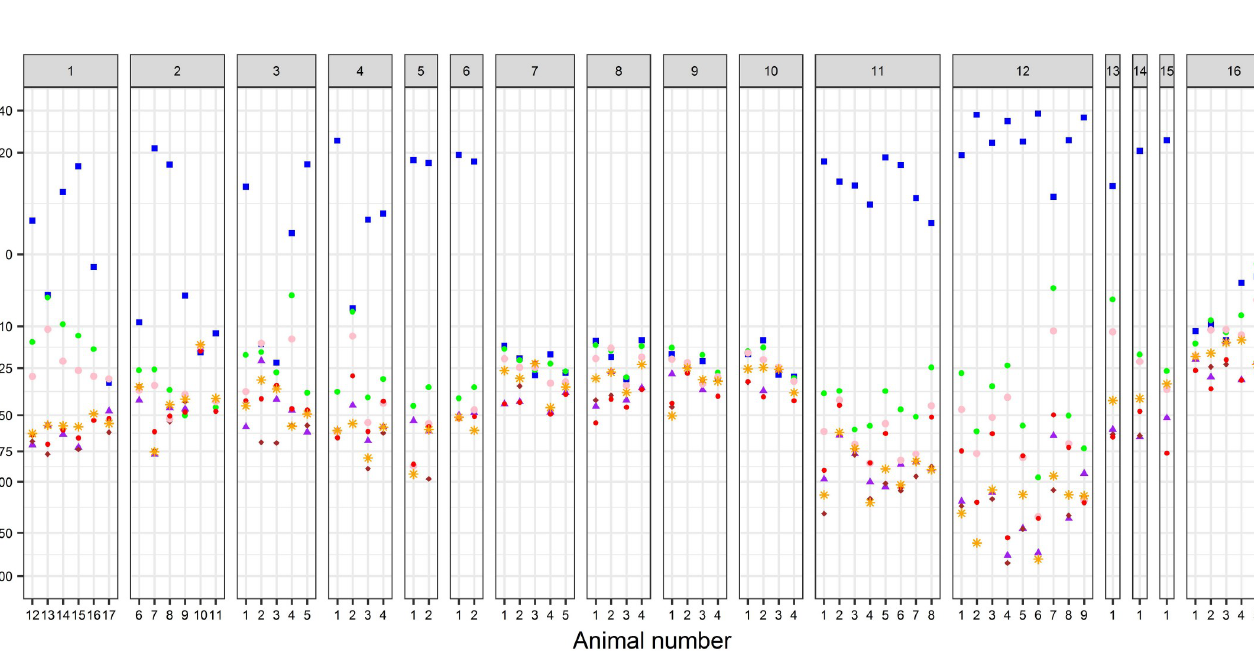
PLOS ONE | https://doi.org/10.1371/journal.pone.0208836 December21,